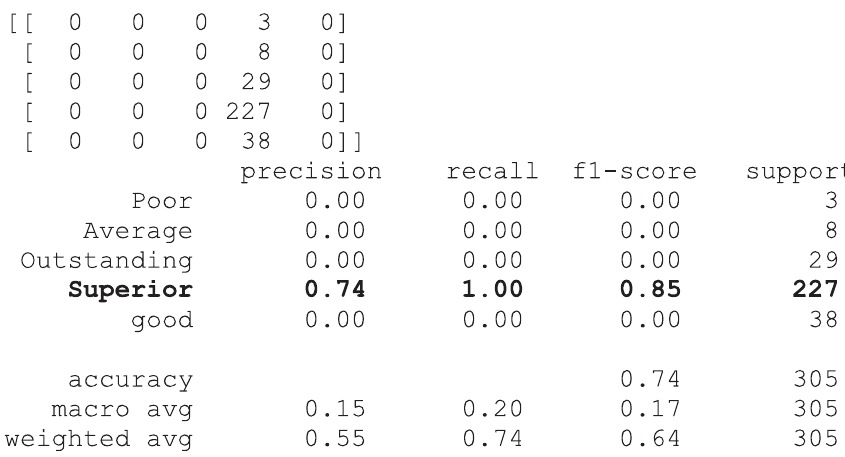
Figure 17: Support vector machine confusion matrix and accuracy results.